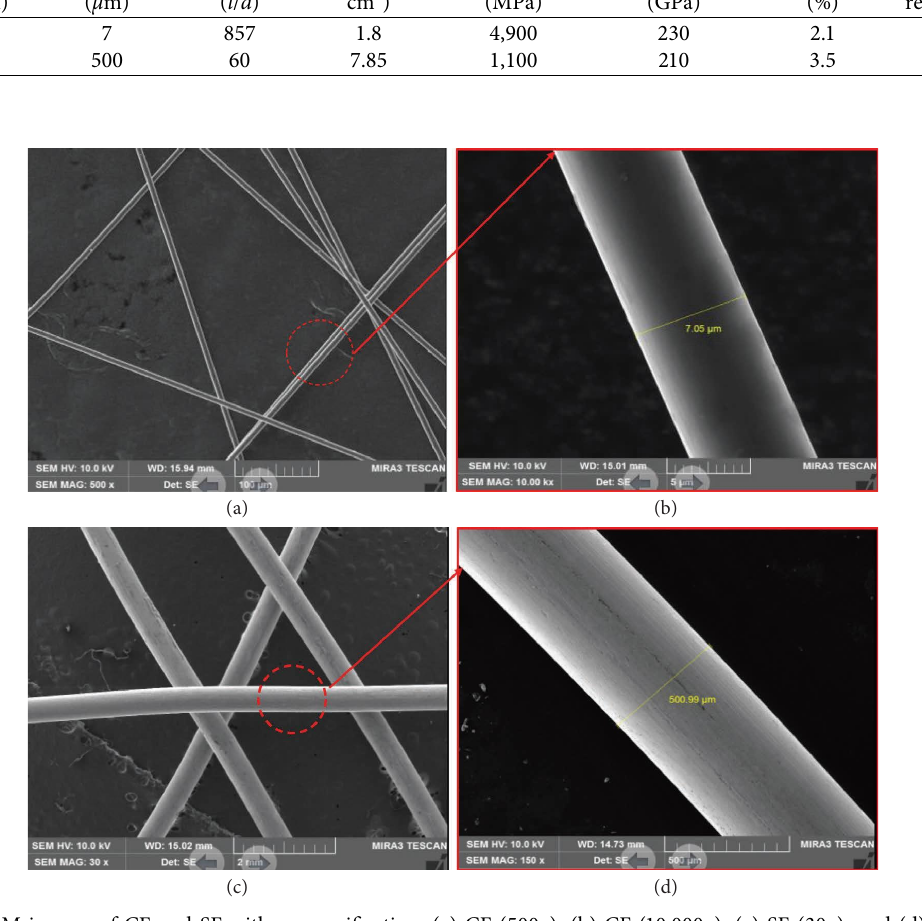
Figure 2: SEM images of CF and SF with a magnifcation. (a) CF (500x), (b) CF (10,000x), (c) SF (30x), and (d) SF